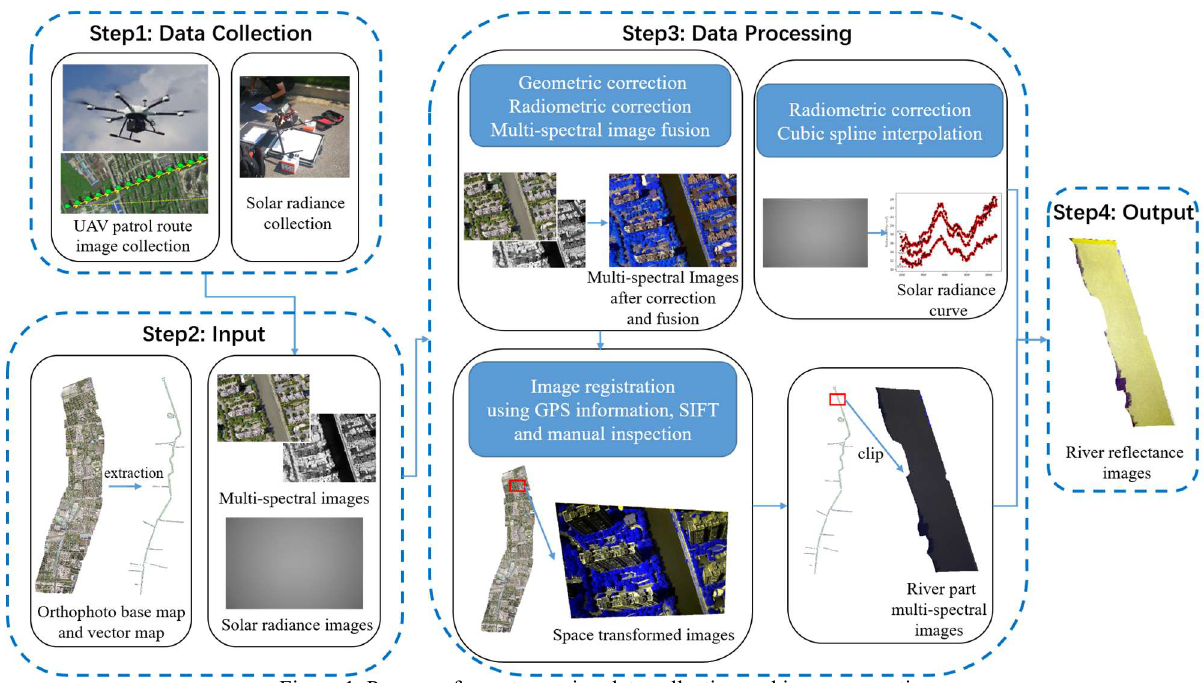
Figure 1. Process of remote sensing data collection and image